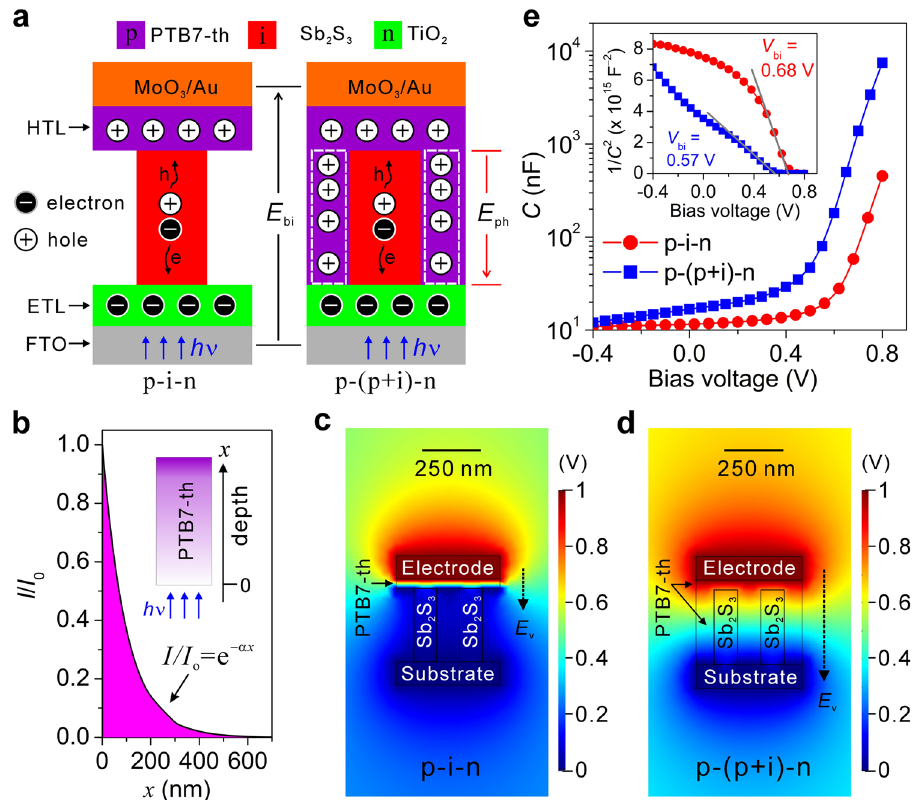
Fig. 5 Architecture-related photogenerated electric fi eld effects. a Architecture-dependent charge distribution model showing the absence and presence of photogenerated electric fi eld ( E ph ) effects in the p – i – n (left) and p-(p + i)-n (right) solar cells during the photovoltaic process, where p means p-type PTB7-th to form hole transporting layer (HTL), i means intrinsic Sb 2 S 3 and n means n-type TiO 2 to form electron transporting layer (ETL). b Light attenuation in the polymer fi lm, where the inset illustrates the distribution of photogenerated excitons in the PTB7-th fi lm along the illumination depth direction with a deeper purple for a smaller exciton population. c , d Simulated electric potential distributions in ( c ) p – i – n and ( d ) p-(p + i)-n solar cells at 1 V forward bias, where, E v stands for the bias electrostatic fi eld, the color gradient bars depict the electric potential, and the substrate and electrode refer to the FTO/TiO 2 and MoO 3 /Au layers in solar cells, respectively. e The capacitance-voltage data in the dark for the p – i – n and p-(p + i)-n solar cells with the highest ef fi